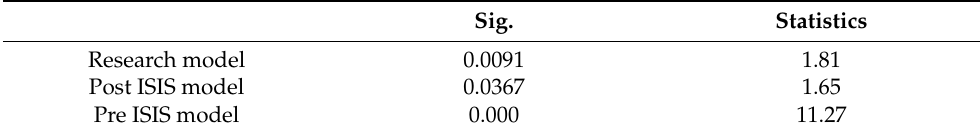
Table 6. The results of pooling.